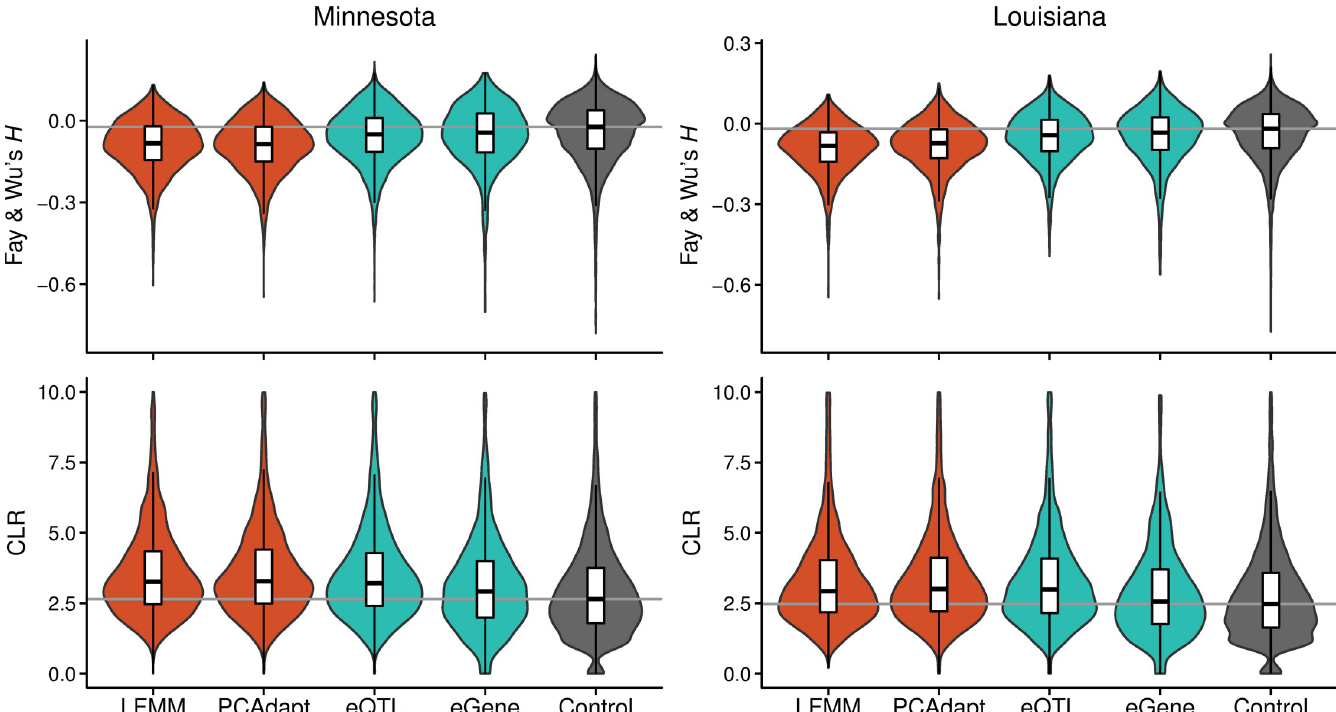
Fig 2. Evidence of selective sweeps at candidate genes. Fay and Wu’s H and CLR distributions of the selection outliers, eQTLs, and eGenes are compared against the rest of the transcriptome for two datasets. The horizontal lines mark the medians of the control genes.